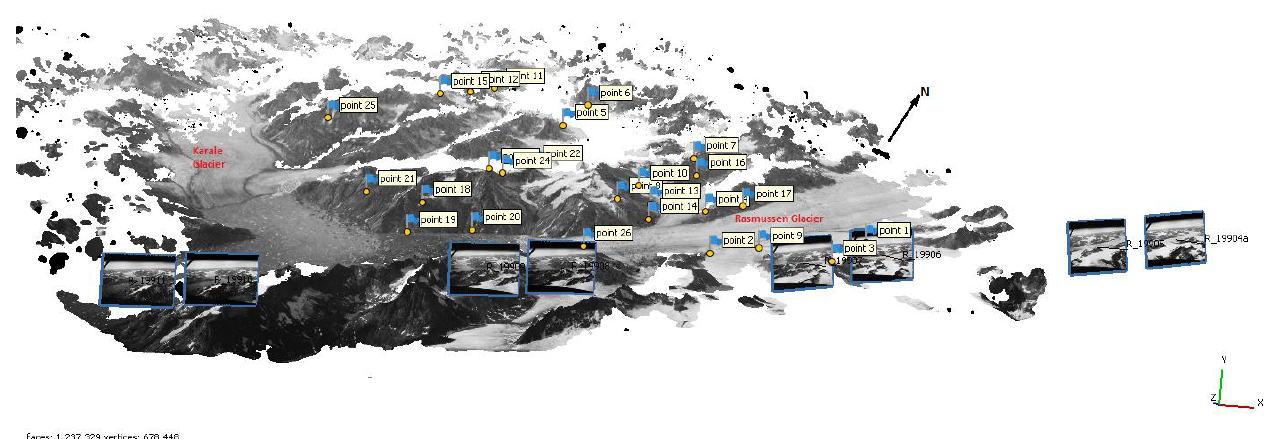
Figure 16. The created three-dimensional (3D) model of Karale ( left ) and Knud Rasmussen glacier mouths ( right ) with tie points and photo positions; 1.23 million faces.